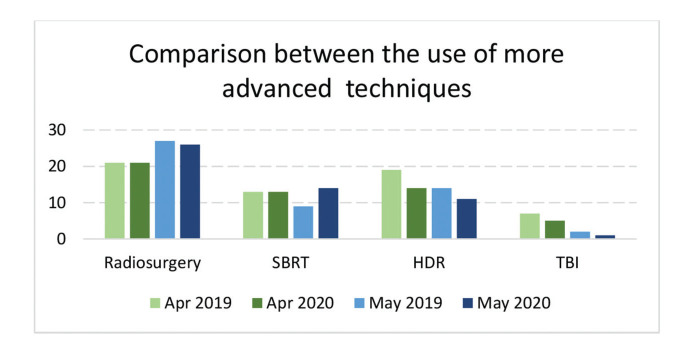
Comparison of the use of other irradiation techniques between the two periods. Legend: SBRT = Stereotactic Body Radiotherapy; HDR = high dose-rate brachytherapy; TBI = Total Body Irradiation.